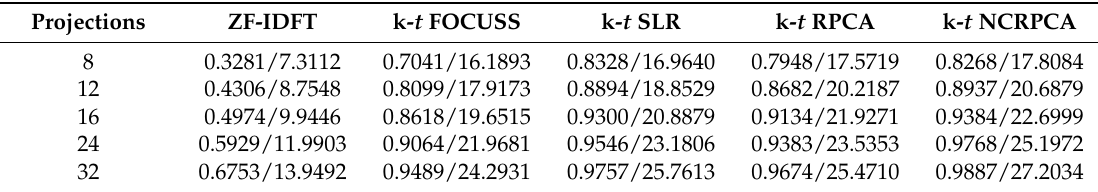
Figure 7. Visual appearance of error images respectively generated by ZF-IDFT, k - t FOCUSS, k - t SLR, k - t RPCA and k - t NCRPCA for different number of radial projections (i.e., 8, 12, 16, 24 and 32). (The images are best viewed in full-screen mode.) Table 2. SSIM/SER comparison of different reconstruction methods on in vivo coronal cardiac MRI dataset for different number of radial